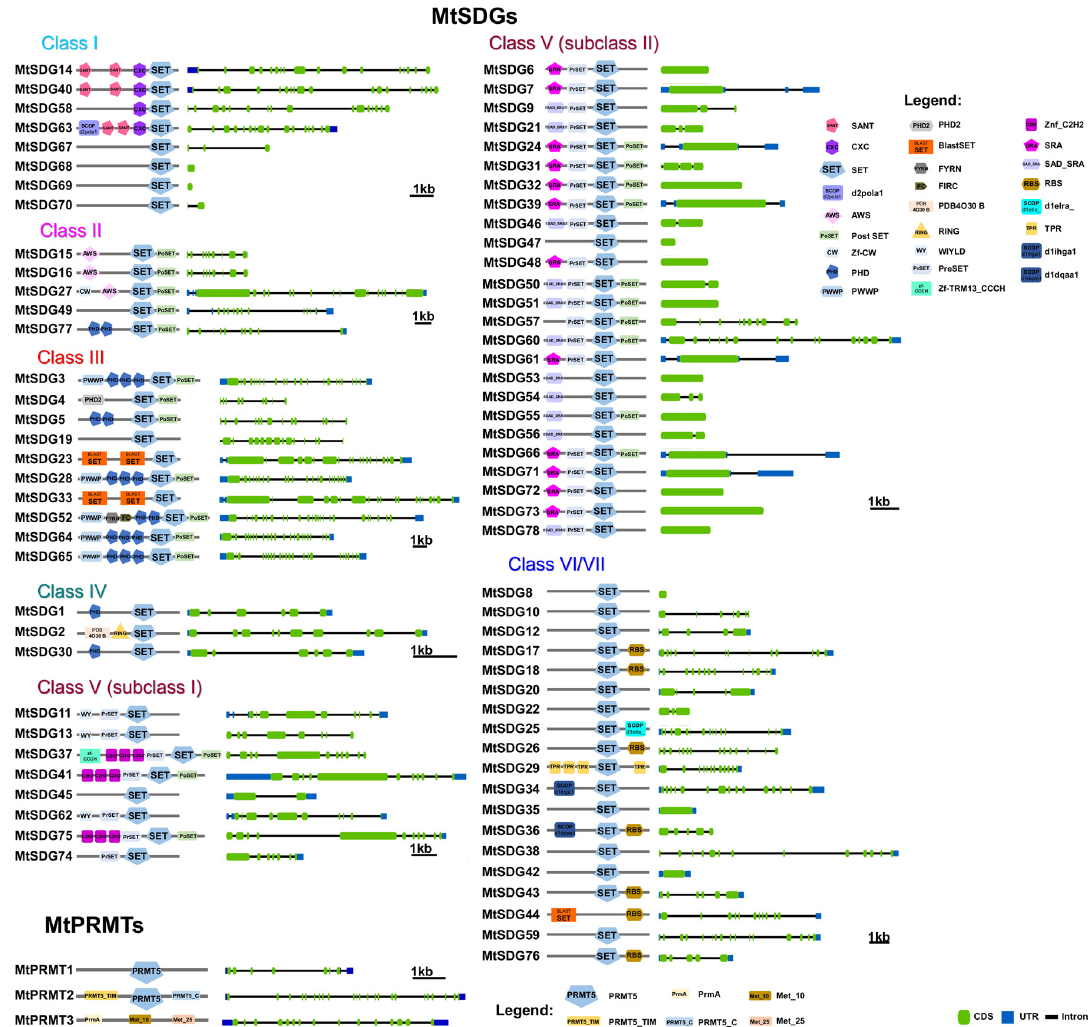
Figure 2. Domain composition and intron-exon structure of M. truncatula